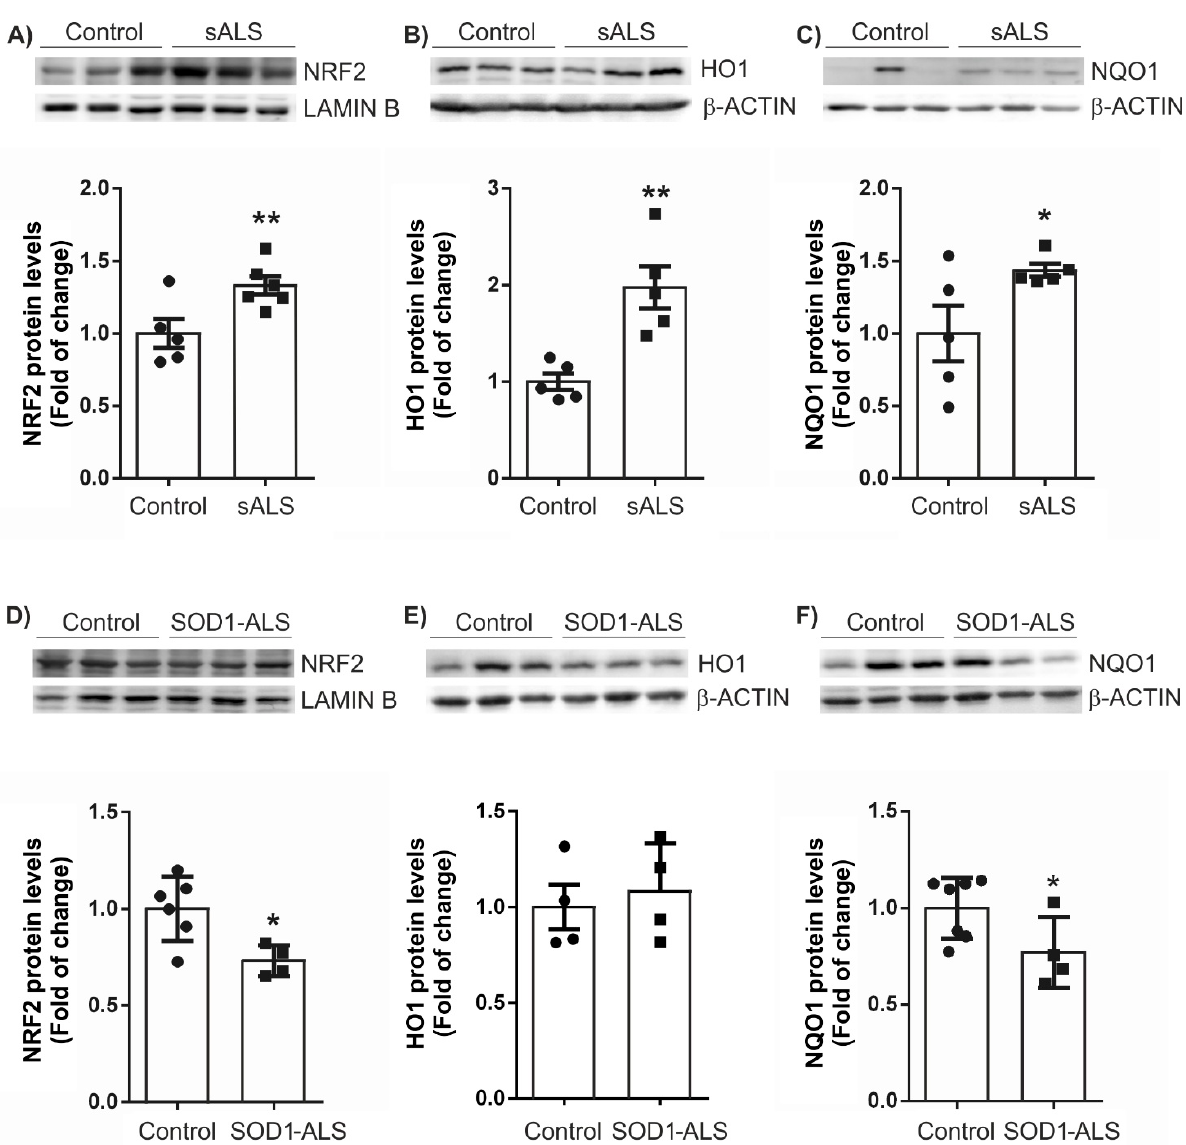
Figure 4. sALS and SOD1 -mutant ALS lymphoblasts revealed significant differences in the NRF2 signaling pathway at the protein level. Immunoblot analysis in whole control and sALS cell lysates of protein levels of NRF2 ( A ) and LAMIN B as a loading control, HO-1 ( B ), NQO1 ( C ), and β -ACTIN as a loading control. Densitometric quantification of representative blots normalized for β -ACTIN. Dots indicate the mean of n = 5 samples ± SEM. Immunoblot analysis in whole control and SOD1 -ALS cell lysates of protein levels of NRF2 ( D ), HO-1 ( E ), NQO1 ( F ), and β -ACTIN as a loading control. Densitometric quantification of representative blots normalized for β -ACTIN. Dots indicate the mean of n = 5-6 (control) and n = 4 ( SOD1 -ALS) samples ± SEM. Asterisks denote significant differences * p < 0.05 and ** p < 0.01, comparing the indicated groups with the basal condition according to the Student’s t -test.